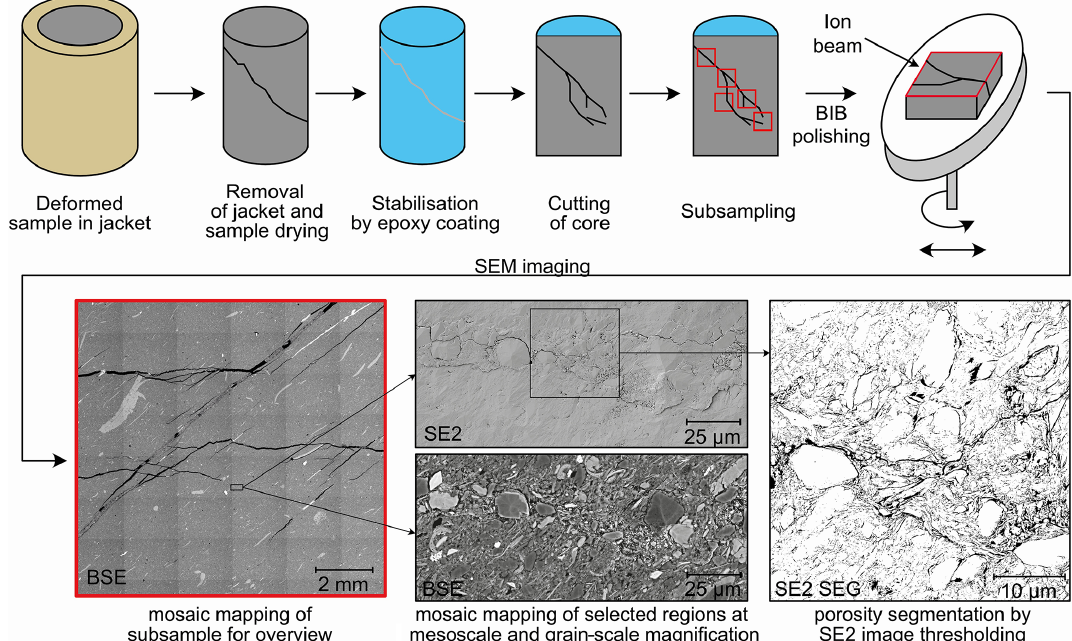
Figure 2. Methodology and sample preparation for the BIB–SEM: after dismantling and sample stabilisation by epoxy resin, the sample was cut normal to the fracture plane. Subsampling followed on selected regions of interest (red boxes), which were subjected to ion beam polishing. Finally, BSE–SEM (back-scattered electron) micrographs were taken at low magnifications (110 × to 200 × ), and detailed high- resolution SE2 (secondary electron) and BSE–SEM images were produced from regions of interest. Pore segmentation was carried out by threshold segmentation of SE2